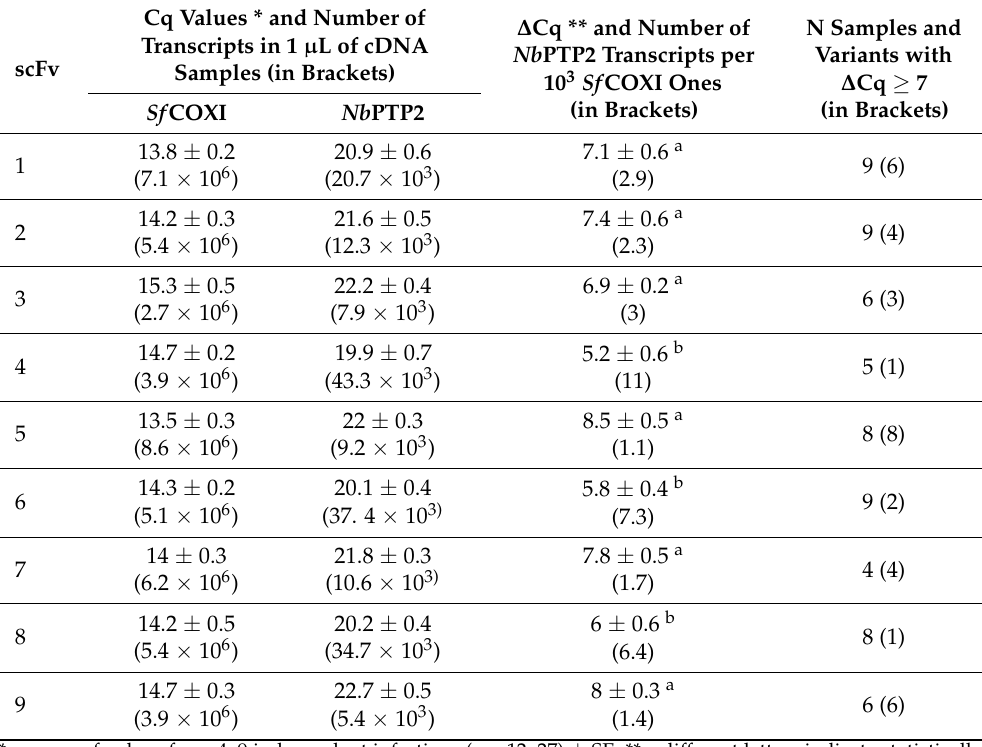
Table 2. Real-time qPCR analysis of N. bombycis PTP2 and S. frugiperda COXI transcripts in scFv- expressing Sf9 transformants infected with 20 microsporidia spores per insect cell and cultured